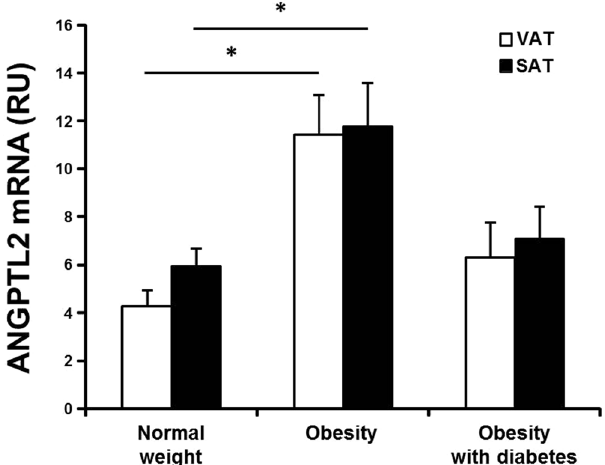
Figure 1. ANGPTL2 mRNA expression in human adipose tissues. ANGPTL2 mRNA in the VAT and SAT of the normal-weight control (n = 32), non-diabetic obesity (n = 31), and obesity with type 2 diabetes (n = 14) groups. β -actin was used as the reference gene; ANGPTL2 mRNA levels are presented in relative units (RU). Data are log-transformed for statistical analysis and shown as the mean ± SE on the original (back-transformed) scale. * p < 0.05 vs . the corresponding fat depot in the control group by ANOVA with Tukey’s test.